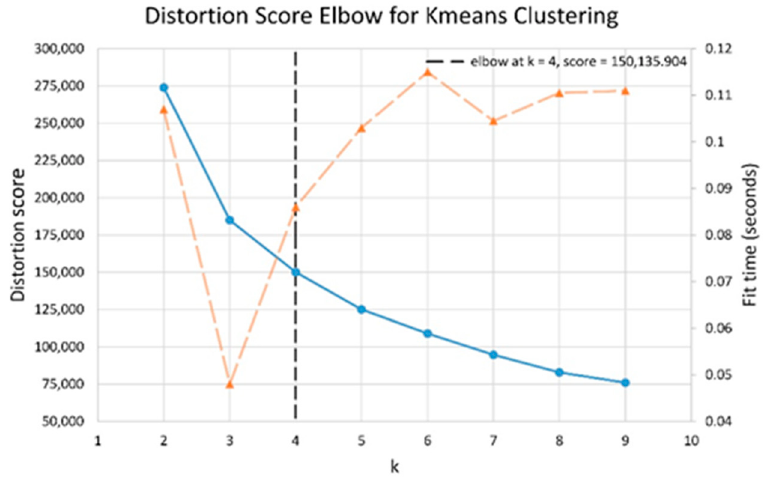
Figure 7. Elbow method results for K-means clustering algorithm (blue line indicates distortion score, and orange dashed line indicates the time to train the clustering model). Table 2. Descriptive statistics (mean (SD)) of trunk, hip and knee range of motion for each cluster between